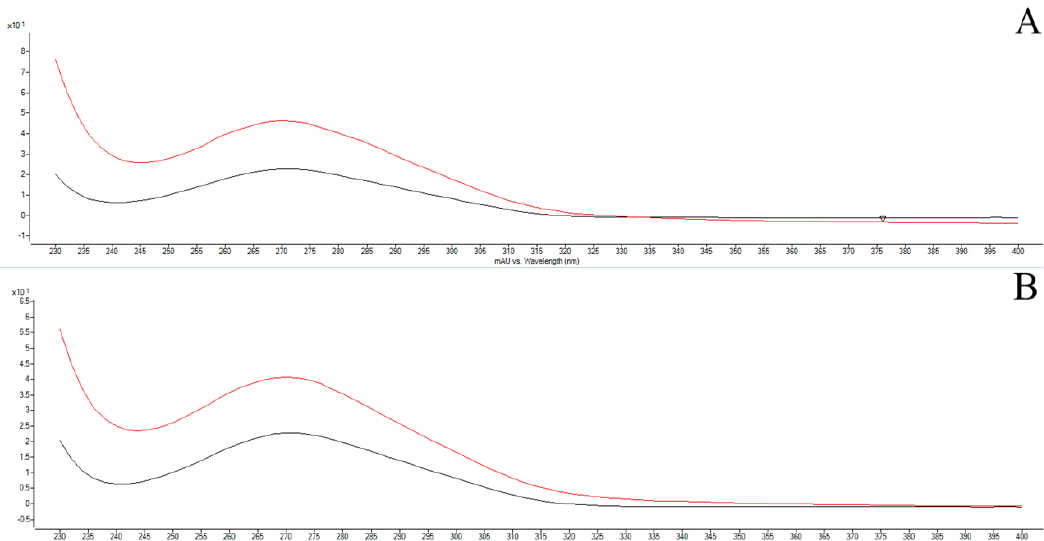
Figure 3. Spectrum of the standard of gallic acid, caffeic acid and spectrum referring to these sub- stances in the crude extract and microparticle.